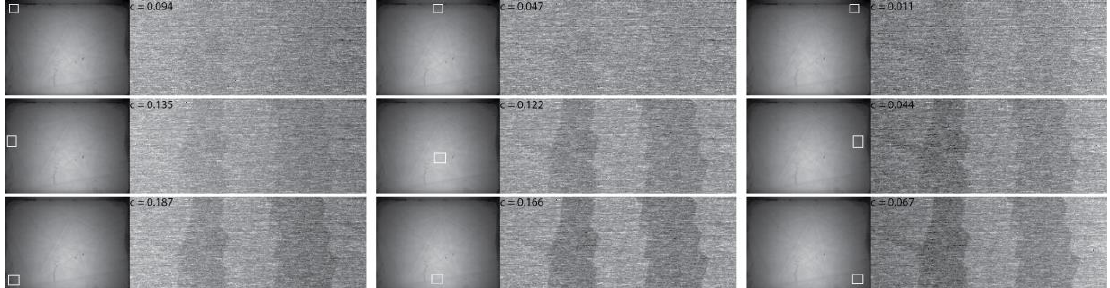
Figure 9. Magnetic domain images (right) obtained from the same EBSD scan as Figure 8. The reference image is displayed on the left of each domain image with the white square defining the collection area used for the image reconstruction. The scalebar displayed on the FSD image in Figure 8a applies to all the images of the figure.